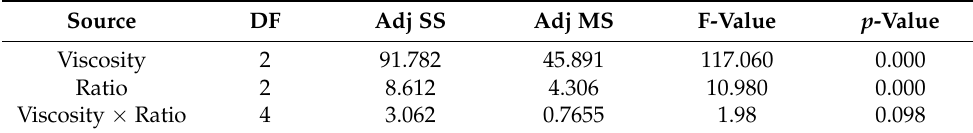
Table 3. ANOVA table for microtube diameter.